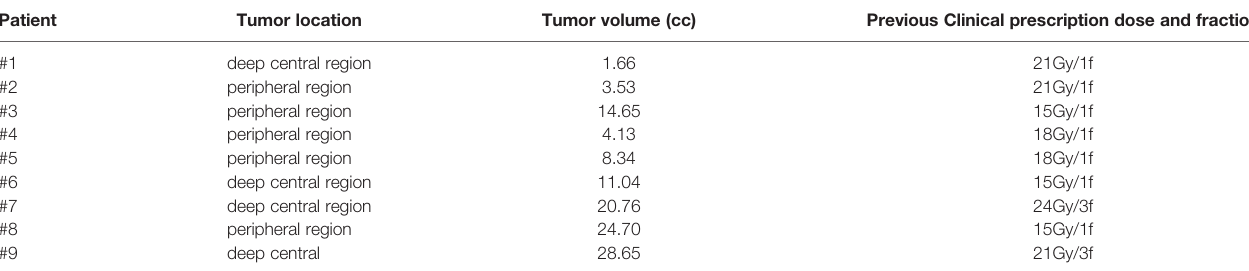
TABLE 1 | Target size and previous clinical prescription for the 9 patients included in this SRS study